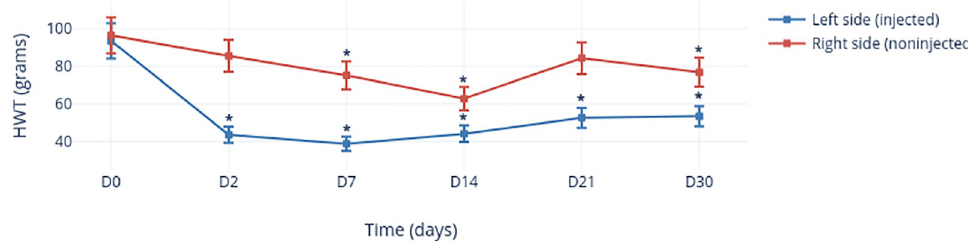
Fig 4. Change in the HWT of TMJs with/without MIA injection as a function of time. � Significant values.